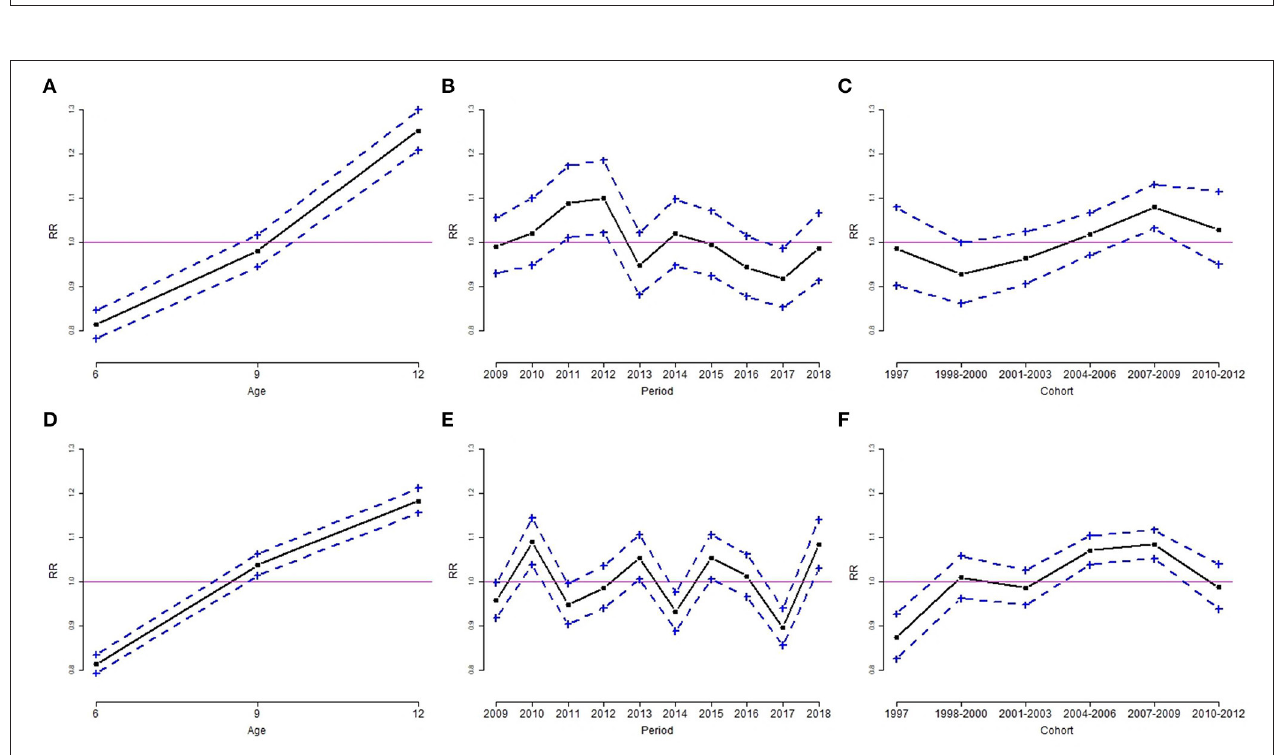
FIGURE 4 | Age, period, and cohort effect of the rate ratio (RR) of obesity by sex group, for boys (A–C) and girls (D–F) . (A,D) : age effect; (B,E) : period effect; (C,F) : cohort effect. Results are RR (solid line) and 95% confidence interval (dotted line). The solid horizontal line represents RR = 1.